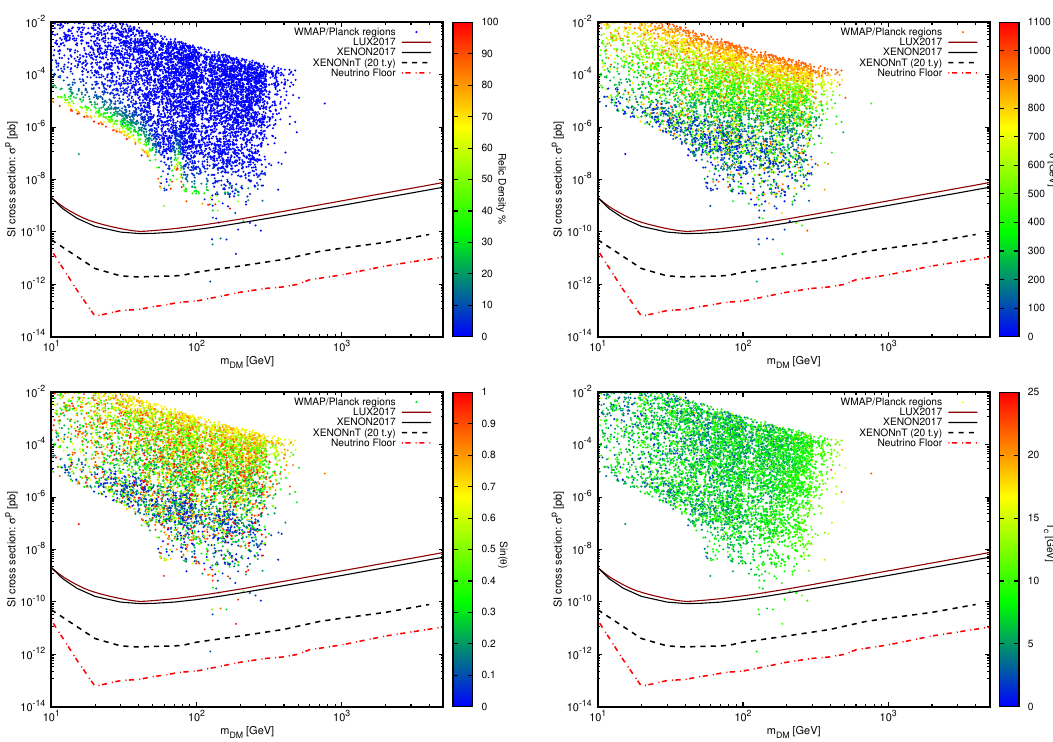
Figure 3 . Scenario 2.1.4 in model without s - s 0 cross-coupling terms: in all plots, the spin- independent DM-proton elastic scattering cross section as a function of the DM mass are shown and compared with the DD experimental upper limits from LUX, XENON1T, XENONnT projec- tions and the neutrino background. This phase transition channel gives rise to a DM model which includes only a fraction of the relic density with the DM mass in the range 127 (cid:0) 277 GeV. The ver- tical color spectrum in all plots indicates, upper-left) the fraction of the observed relic abundance, upper-right) the mass splitting (cid:14) , lower-left) the variation of the mixing angle sin (cid:18) and lower-right) the critical temperature T c